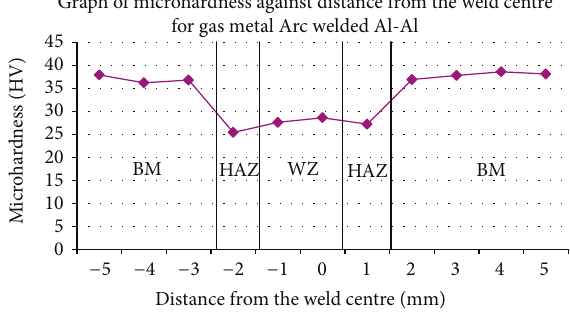
Figure 17: The microhardness profiles of Al-Al joint fabricated by